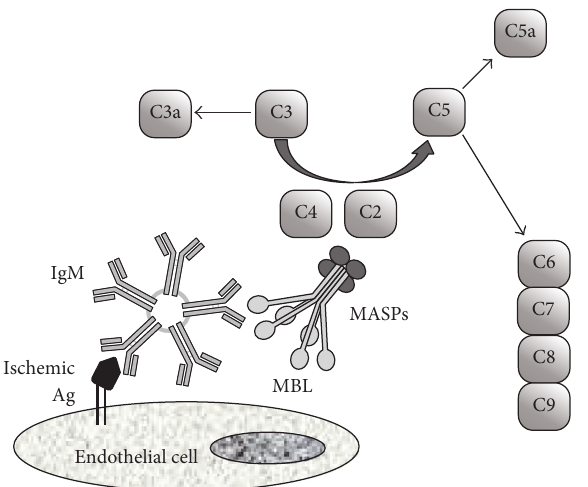
Figure 3: A model illustrates the activation of the lectin pathway by natural IgM in I/R injury. IgM binds to the neoepitope in self-Ag and activates the lectin pathway of complement. The downstream events include the releasing of proinflammatory factors C3a and C5a, deposition of the membrane attack complexes C5–C9, recruitment of inflammatory cells, and leading to direct cell damage [38].